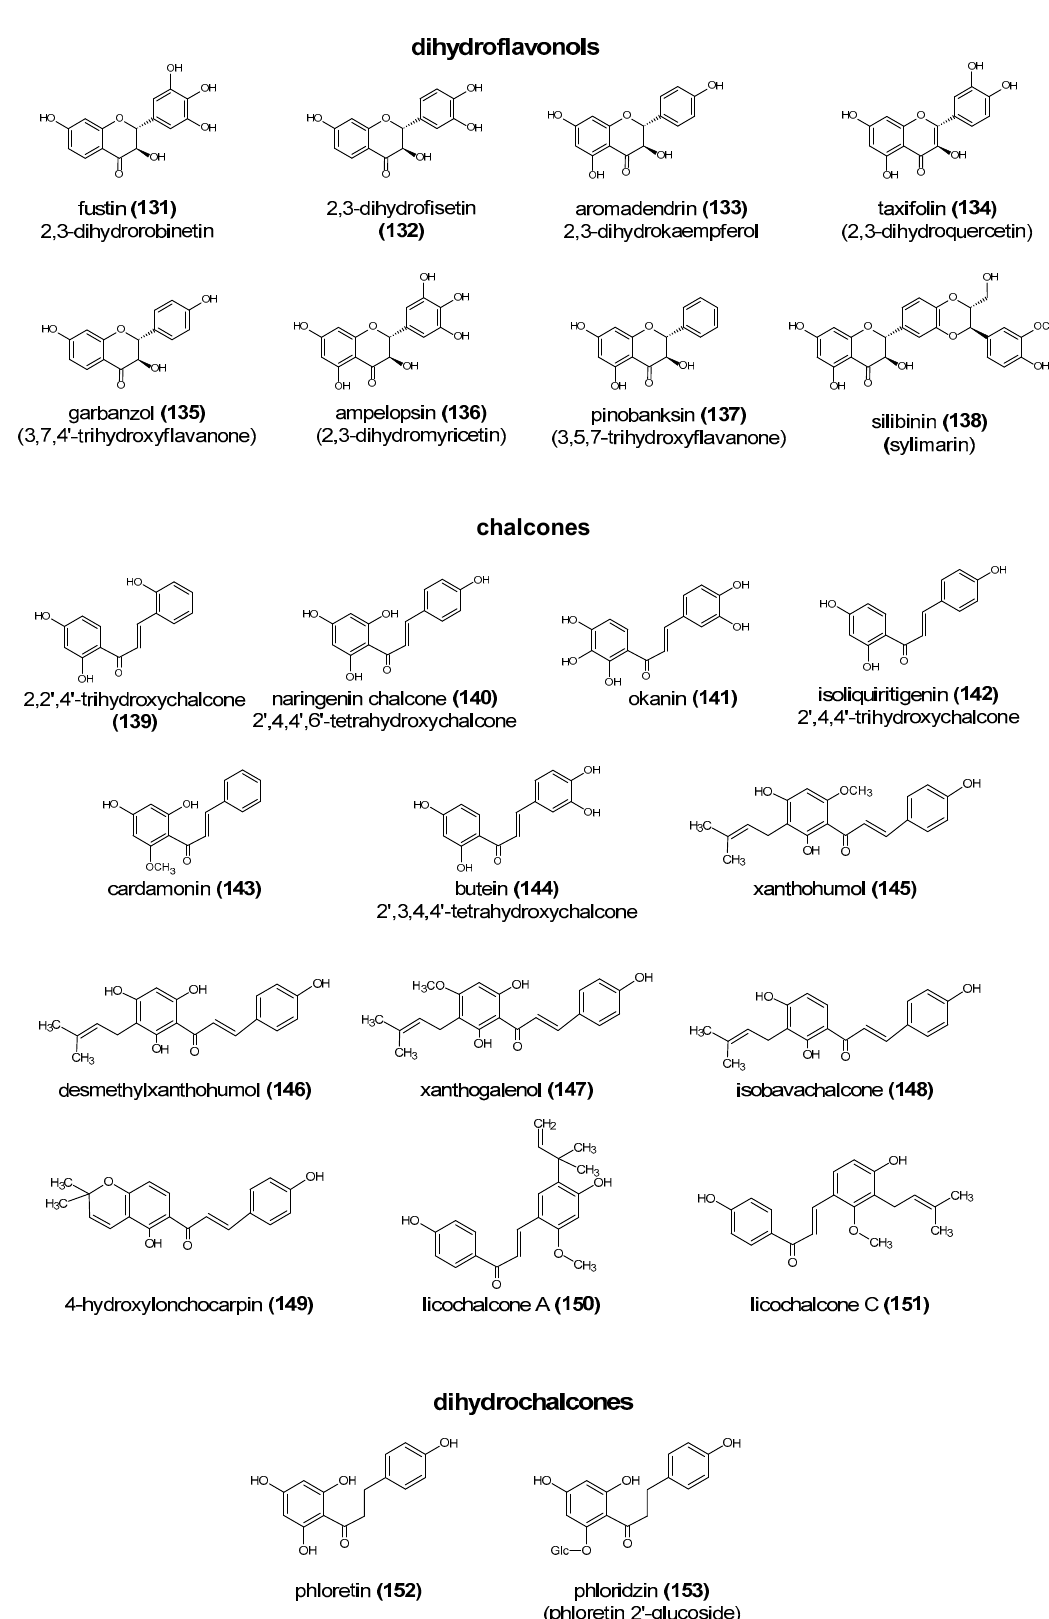
Figure 1. The chemical structure of various classes of flavonoids. Based on [16,24,33–40].